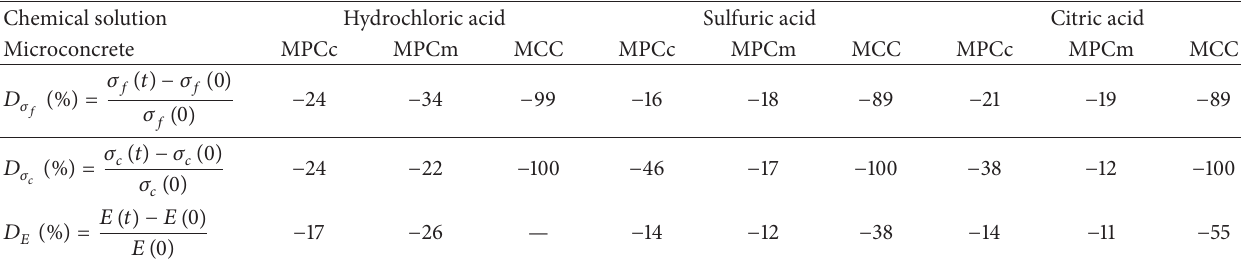
Figure 7: Evolution of the damage parameter related to compressive strength, 𝐷 𝜎 Table 7: Different indicators of the degradation of the selected